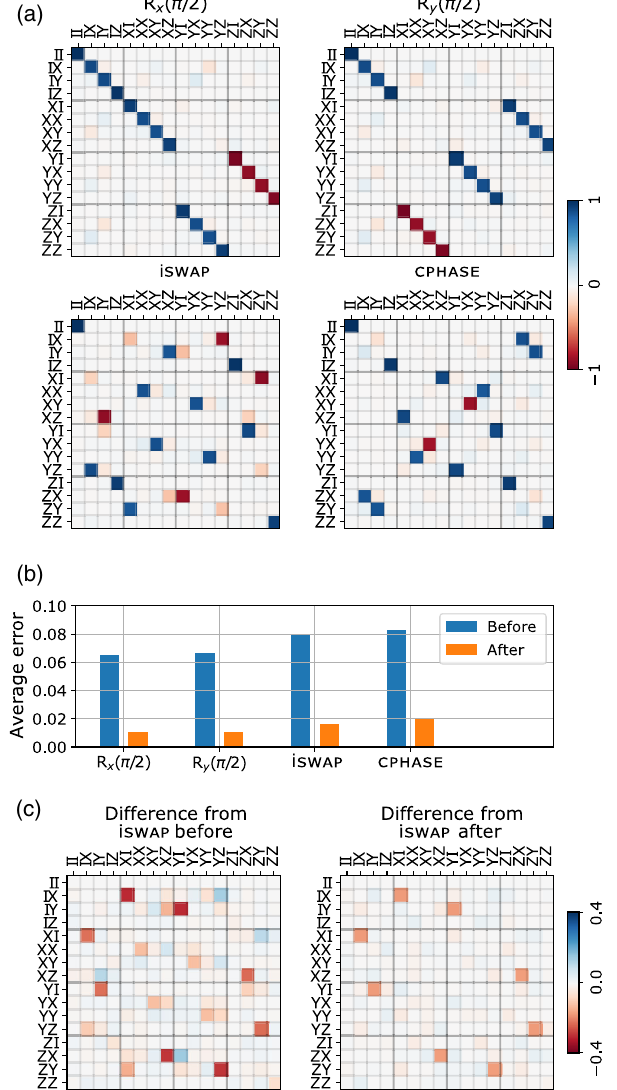
FIG. 4. (a) Pauli transfer matrices of the π = 2 pulses on the control qubit, the i SWAP and the c PHASE gate, extracted in the first round of QPT. We do not show transfer matrices of ideal gates since they are essentially equal to the experimental matrices with all matrix elements rounded to − 1 , 0, or þ 1 . (b) Average errors of the extracted processes (calculated as 1 − average fidelity of the process) before and after the iterative procedure. (c) Deviation of the extracted i SWAP Pauli transfer matrix from the ideal value, before and after the iterative